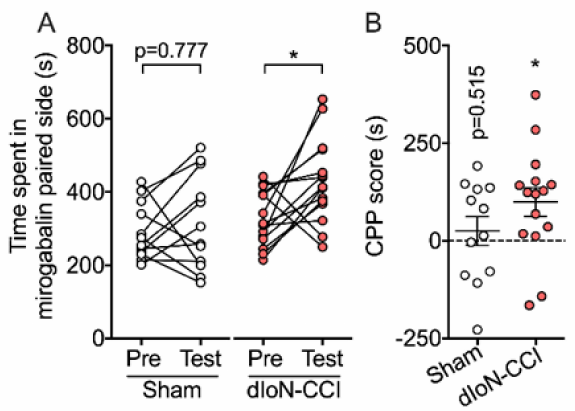
Figure 2. Conditioned place preference (CPP) in sham and IoN-CCI mice. Mirogabalin (2 mg/kg, i.p.) was injected to each mouse and placed in CPP chamber. ( A ) Total time spent in the mirogabalin-paired compartment during the pre-conditioning (pre) and post-conditioning (post) test sessions. Sham ( n = 12) and dIoN-CCI ( n = 15). Mice with a dIoN-CCI developed a preference for the mirogabalin- paired compartment, whereas sham mice showed no preference. Individual data and mean ± SEM are shown. * p < 0.05 compared with pre-conditioning (two-way RM ANOVA followed by Sidak’s multiple comparisons test). ( B ) total CPP scores. sham ( n = 12) and dIoN-CCI ( n = 15). Data are expressed as mean ± SEM. * p < 0.05 (One sample t